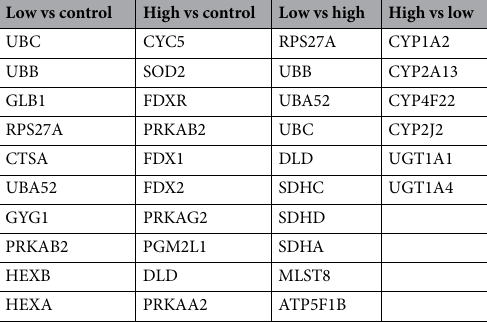
Table 4. Top Reactome leading edge genes related to cell stress, ROS, NOS, and cell metabolism gene sets enriched by low- or high-frequency (vs. control), or low- vs high-frequency tensile